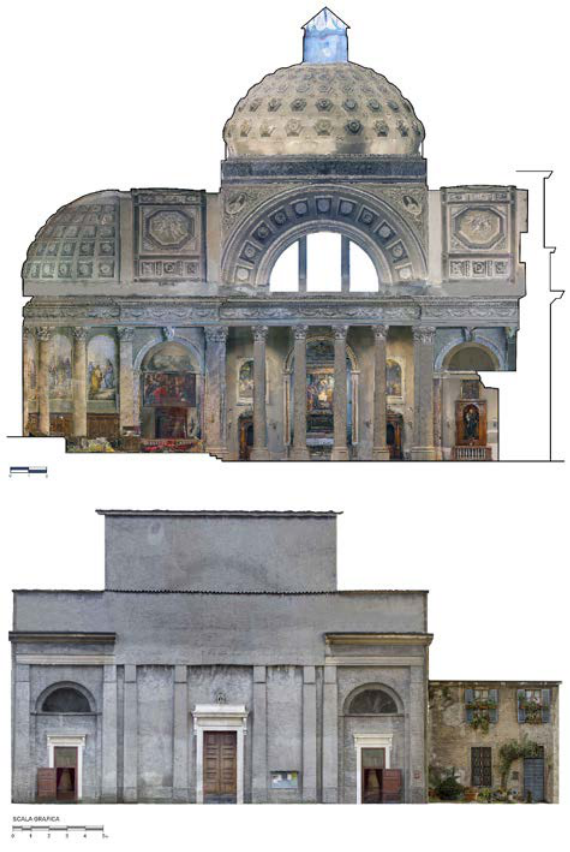
Figure 8. Orthographic projection of the longitudinal section (top) and of the façade